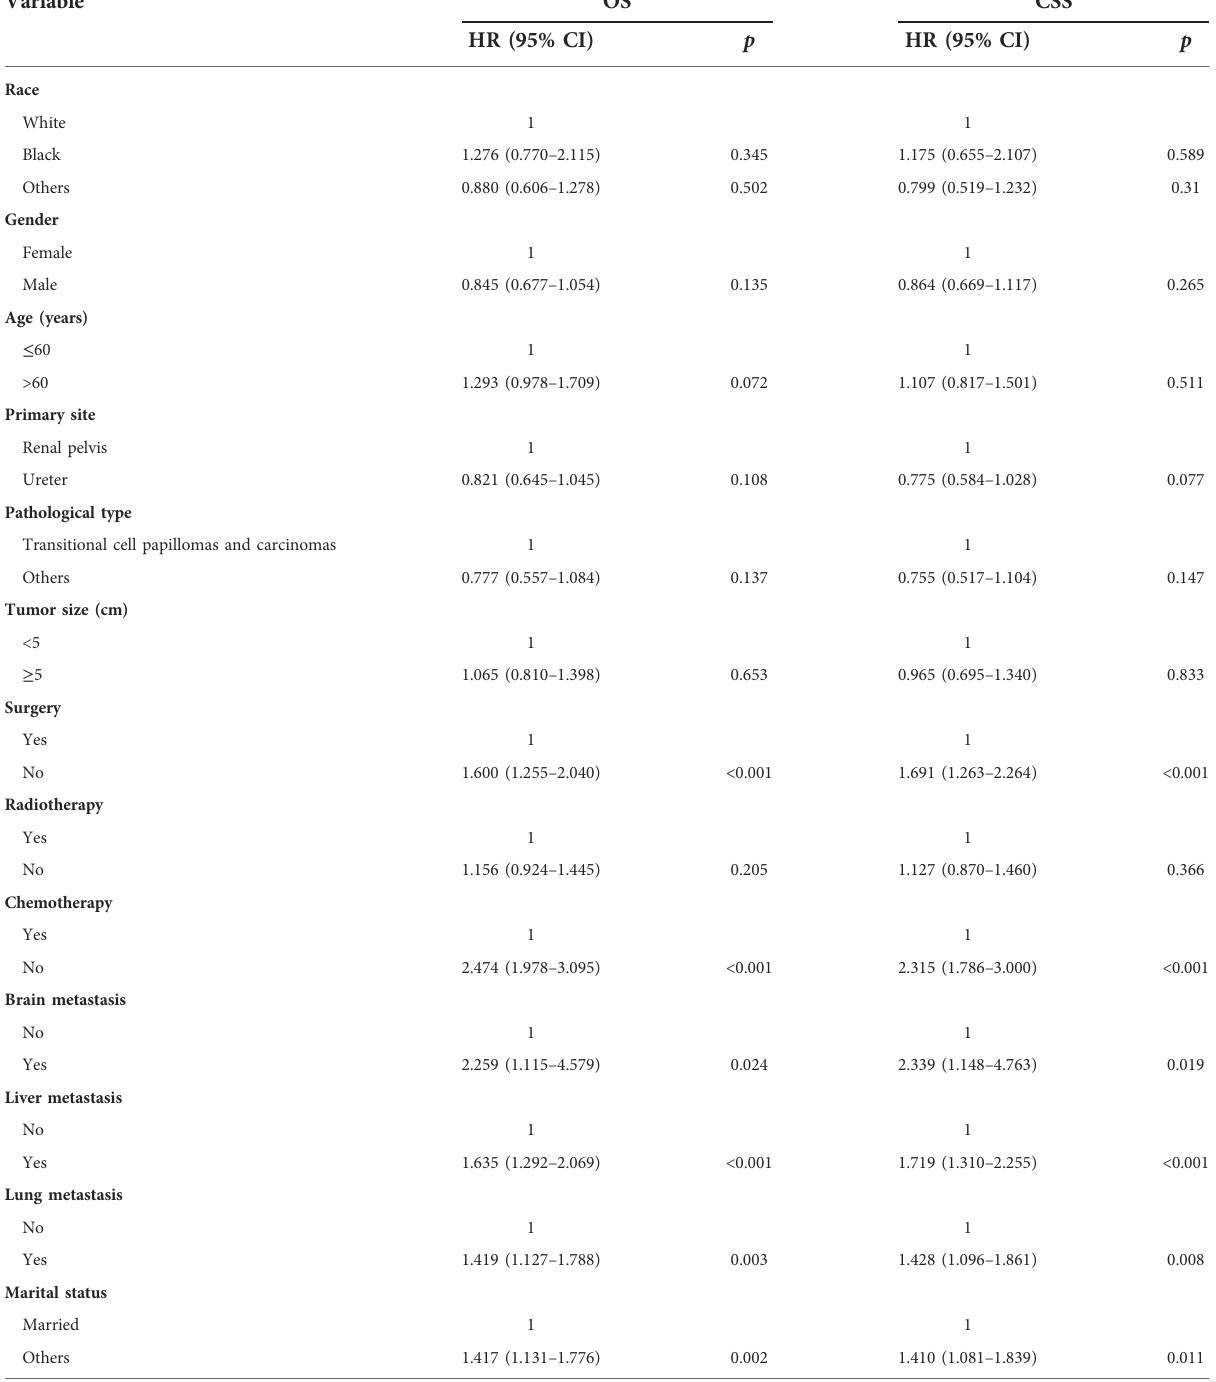
TABLE 2 Univariate Cox analysis of variables in UTUC with bone metastasis.